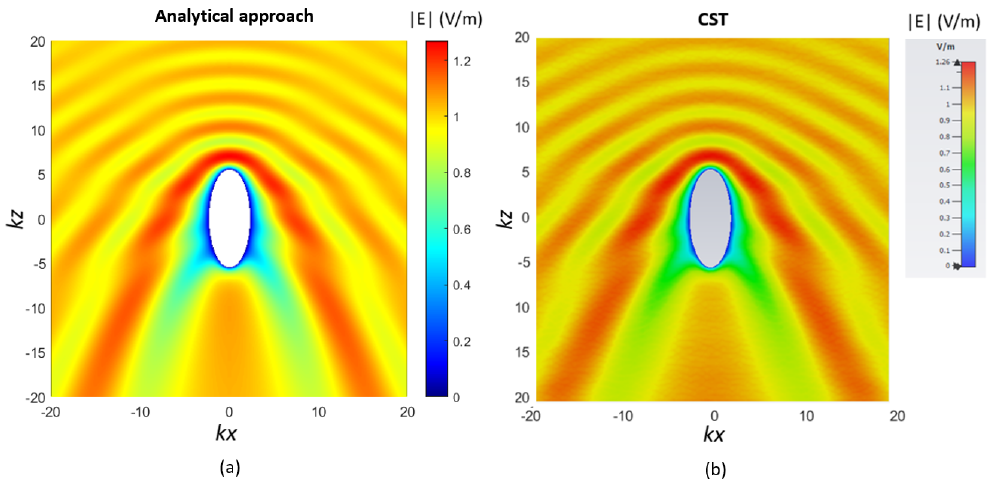
Figure 7. Magnitude of the E-field across the xz -plane for the case of axial incidence ( θ 0 = 0 ◦ ), for the same geometry considered in Figure 2, obtained through the analytical approach in Matlab ( a ) and through CST Microwave Studio ( b ). TE